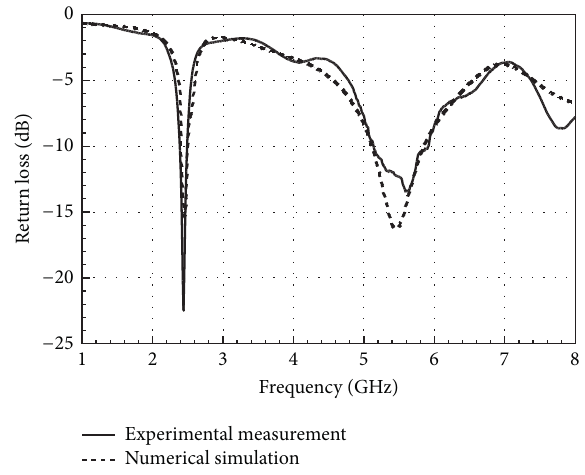
Figure 9: Photograph of the fabricated planar inverted-e-shaped antenna with DGS.